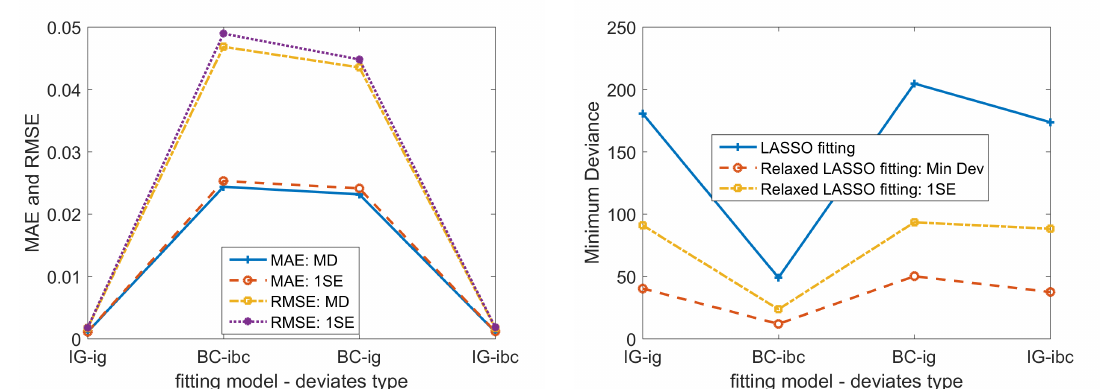
Figure 4. Base case scenario: performance evaluation for optimized fitting models. 1. ( top-left panel ) is precision; ( top-right panel ) is recall; ( bottom-left panel ) is MAE and RMSE; and ( Bottom-right panel ) is deviance. 2. We draw fitting results of minimum deviance λ minimum − deviance and of 1 standard error deviance λ 1 SE , respectively 3. In optimized models, we use λ BC from the three-phase search and optimal IG link function with minimum